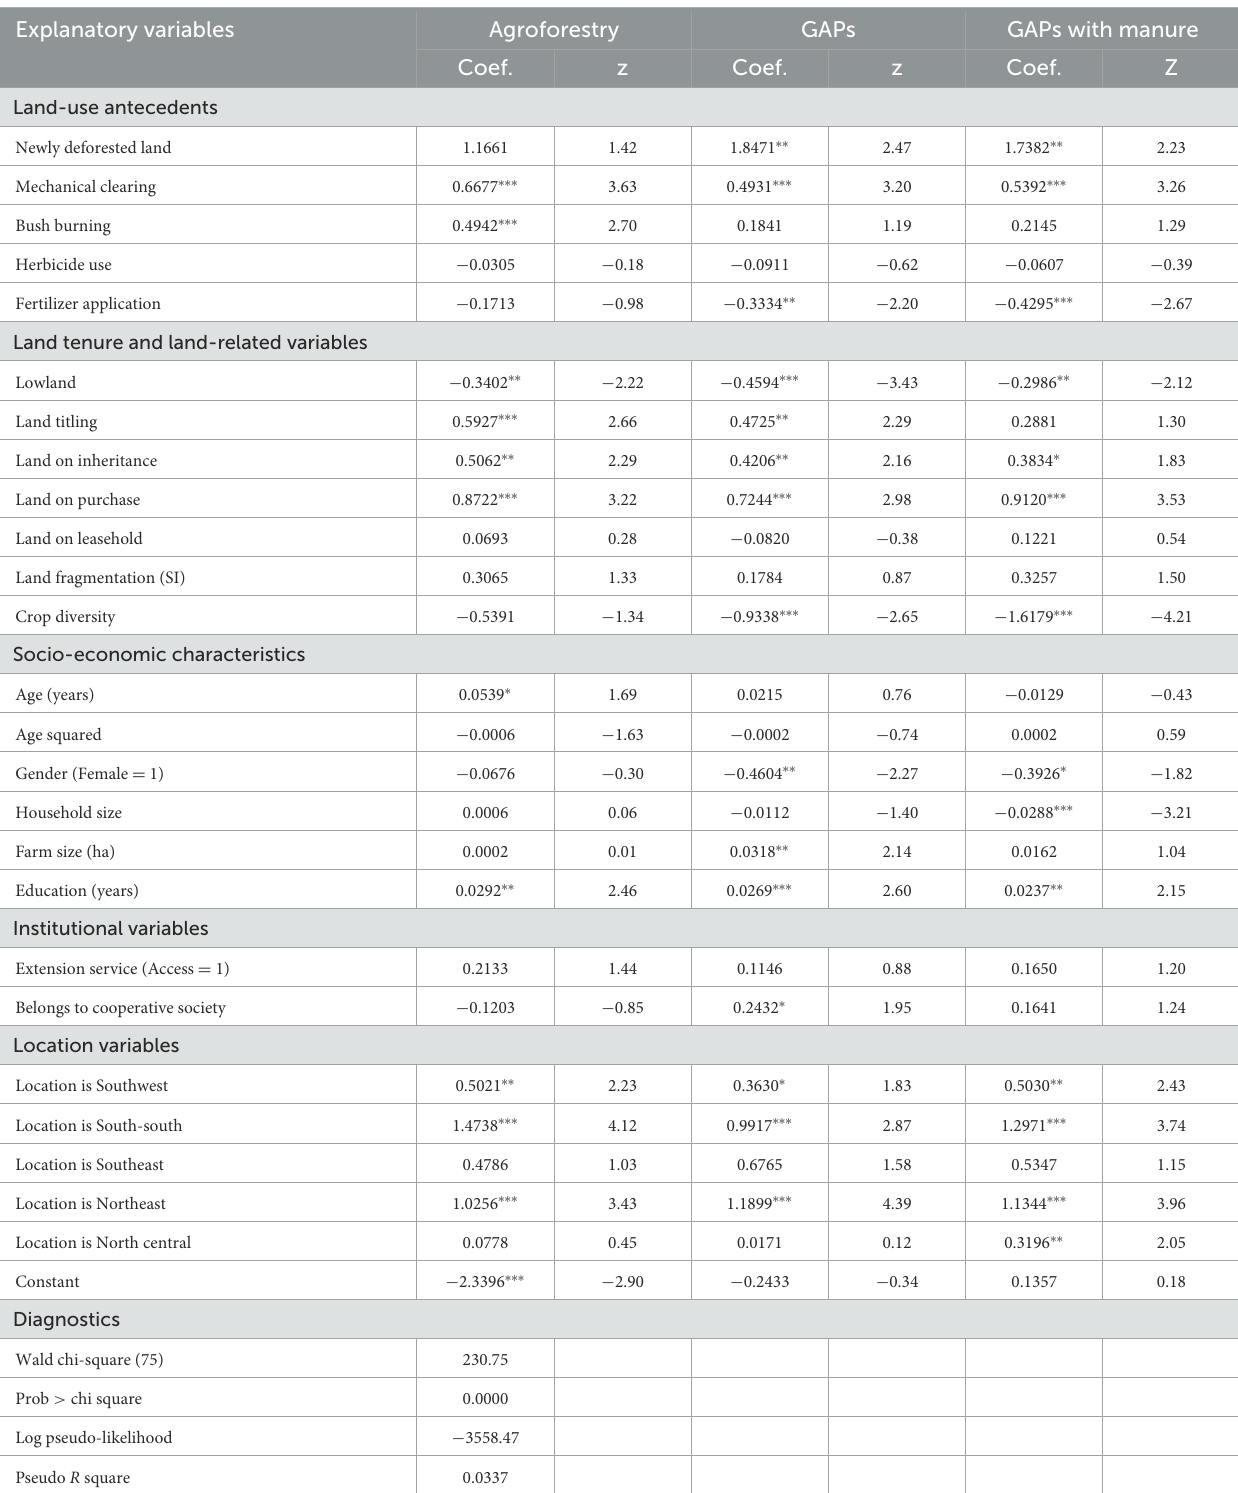
TABLE 3 Influence of land tenure and land use antecedents on RFPs. Explanatory variables Agroforestry GAPs GAPs with manure